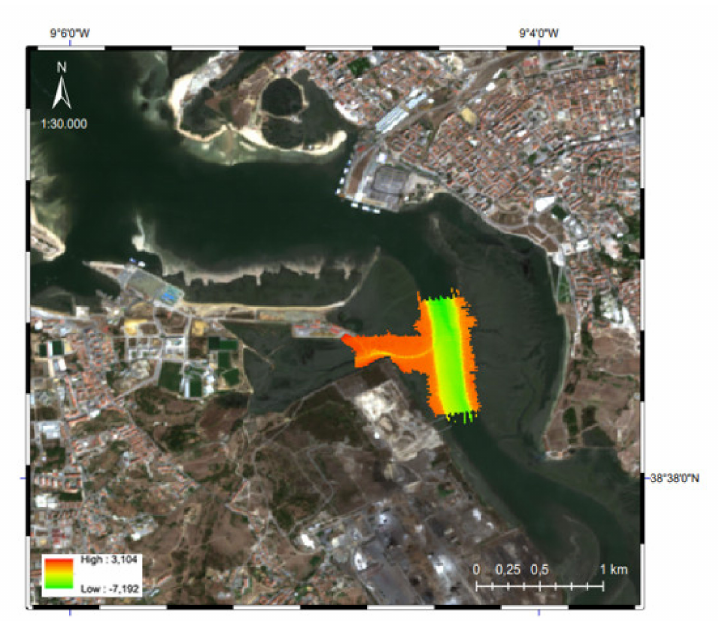
Figure 4. Bathymetric model acquired by hydrographic survey in Tagus estuary—Azinheira area (red: 3.1 m above chart datum and green: 7.2 m below chart datum).